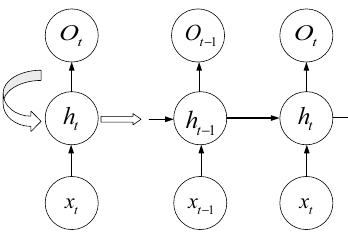
Fig. 4 RNN structure